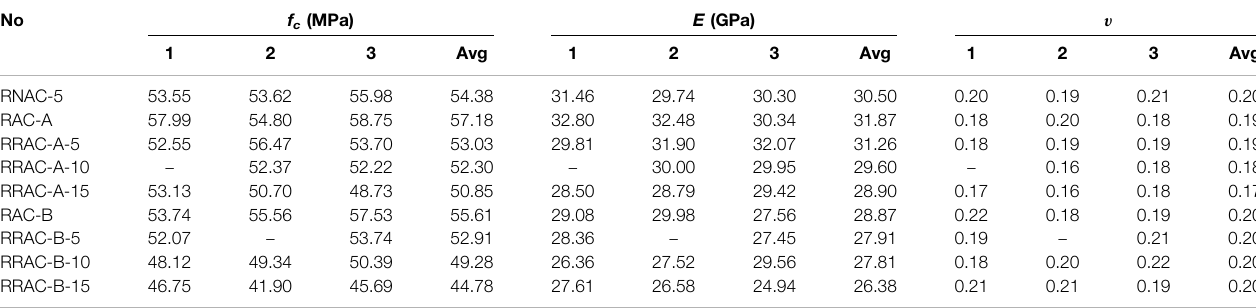
TABLE 4 | Experimental results of compression strength and elastic properties.